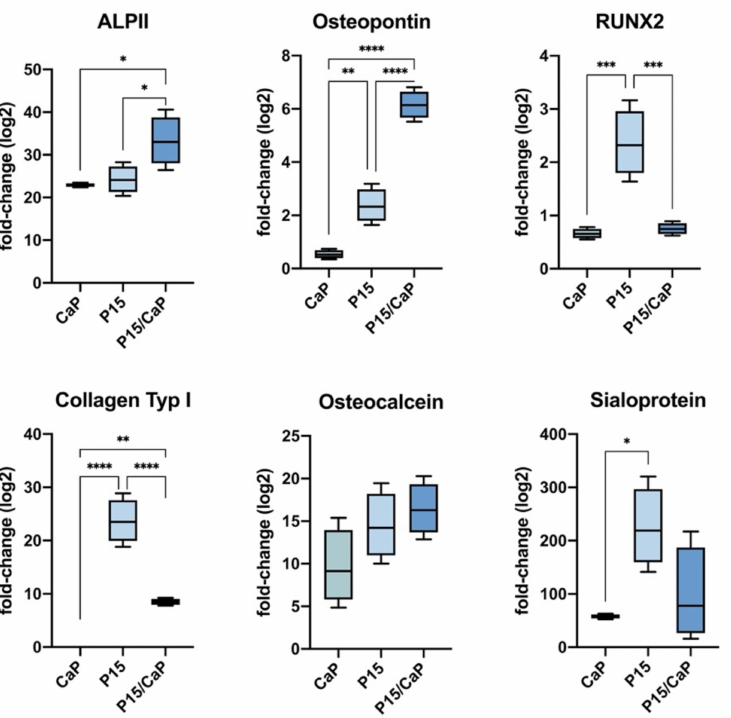
Figure 1. Osteodifferentiation of MESs in vitro. Using RT-PCR, mRNA expression of ALPI II (22.91 ± 0.011-fold, p < 0.0001), osteopontin (0.51 ± 0.1-fold, p < 0.0001), RUNX2 (0.65 ± 0.06-fold, p < 0.0001), osteonectin (2.92 ± 0.1-fold, p < 0.0001), and osteocalcin (8.64 ± 0.41-fold, p < 0.0001) were upregulated after treatment with CPC-P-15. * p < 0.05, ** p < 0.01, *** p < 0.005, **** p < 0.0005. To substantiate osteodifferentiation, immunofluorescence staining of osteopontin and staining of Ca2+ deposits using Alizarin Red were used. MESs were cultured in a growth medium and showed no osteopontin or Alizarin Red labeling. When treated with CPC/P-15, osteopontin and Ca2+ deposits, colored red by the Alizarin Red staining, were detected after 10 days (Figure 2A,B).